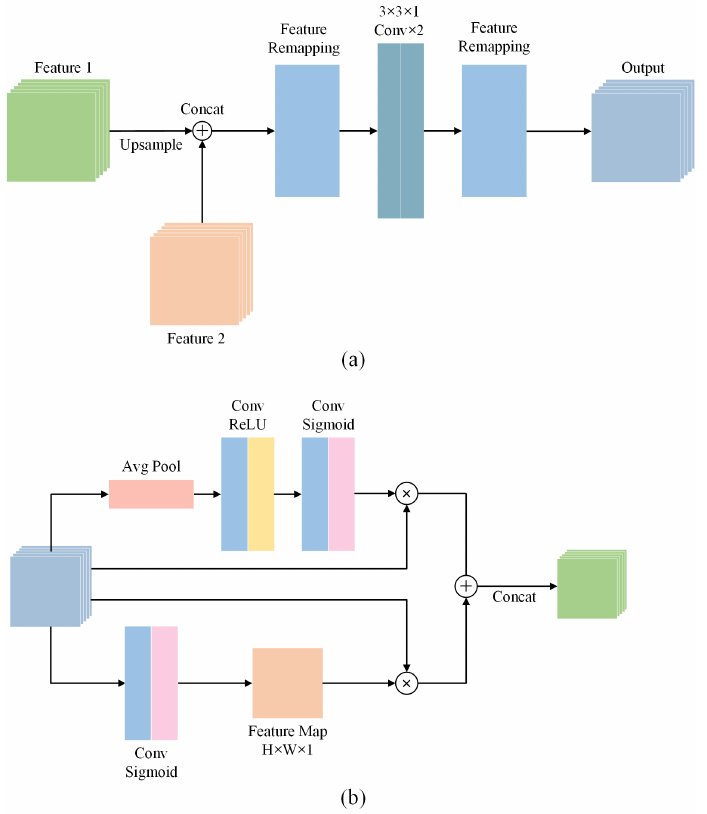
Figure 3. Architecture of decoding blocks. ( a ) Detailed structure of decoding blocks. ( b ) Detailed structure of feature remapping modules in the